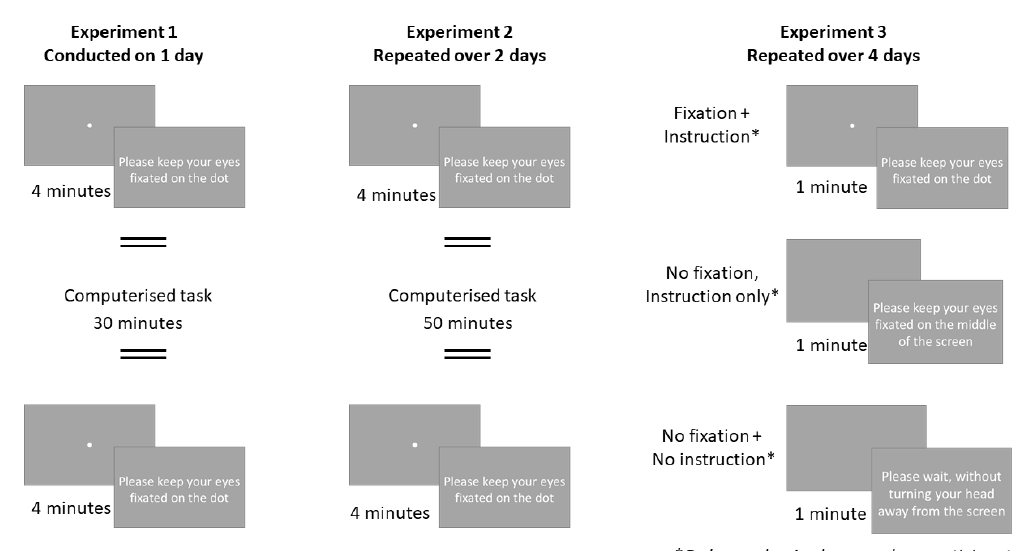
Figure 2. Overview of the resting state eye movement paradigms of all three